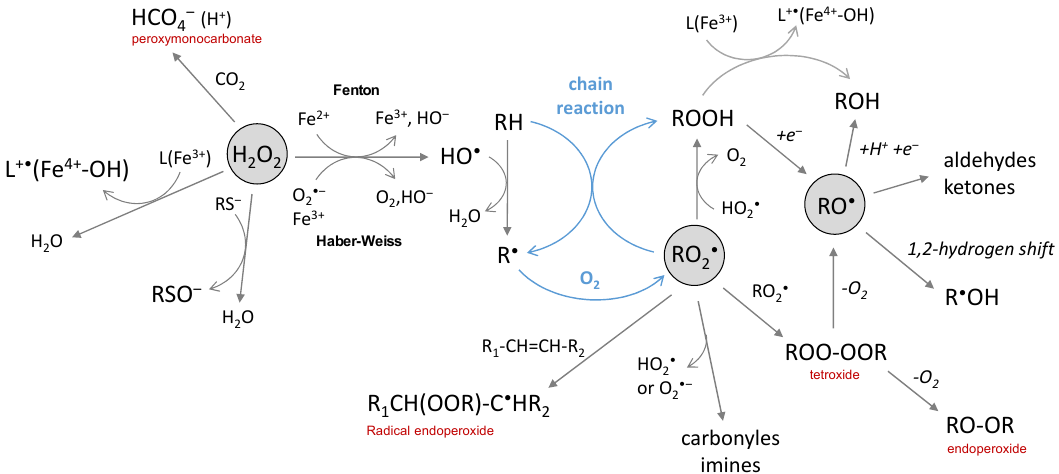
Figure 4. The chemical reactions of hydrogen peroxide, peroxyl and alkoxyl radicals.